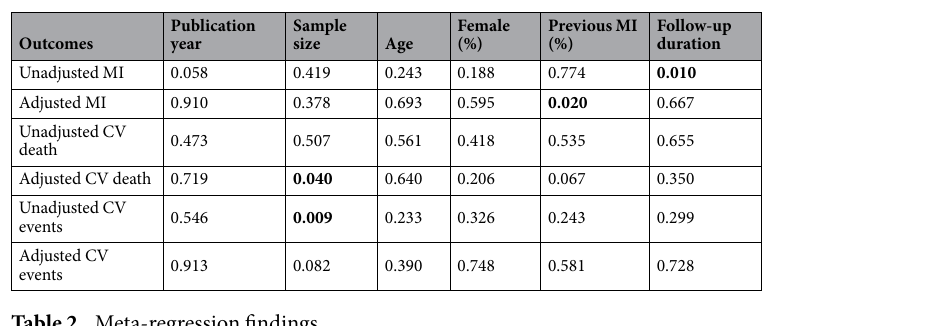
Table 2. Meta-regression